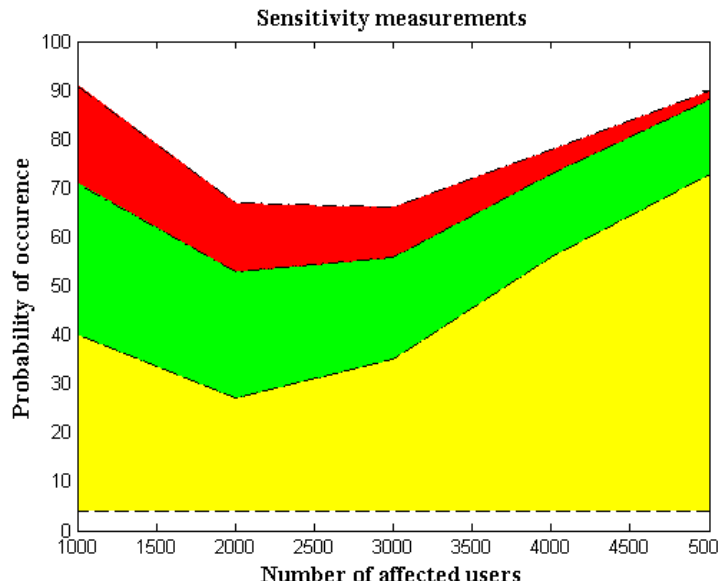
Figure 5. Measurements of sensitivity.